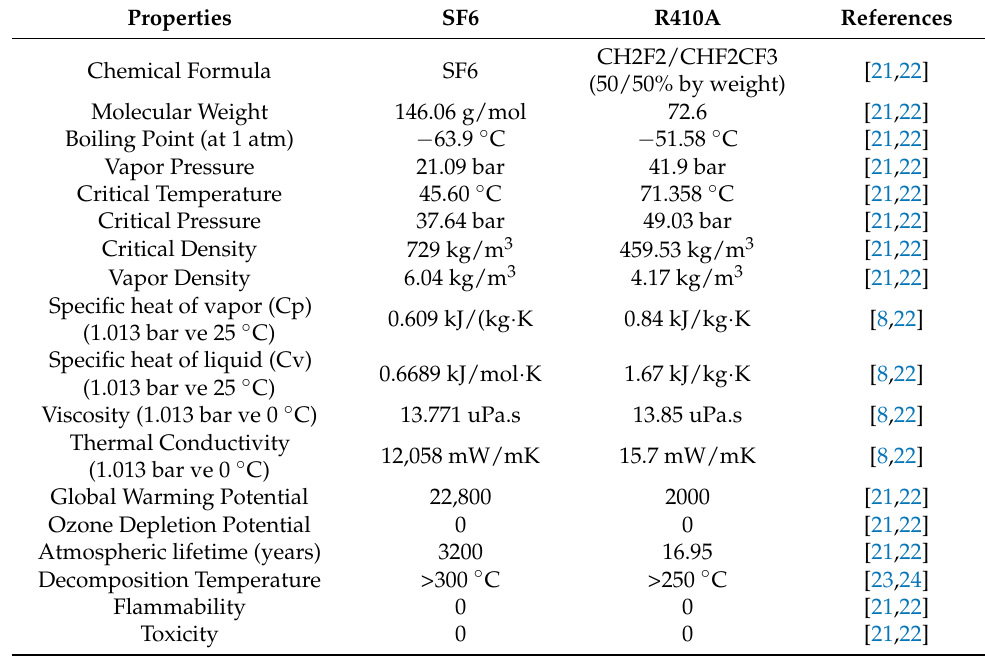
Table 2. SF6 and R410A basic physical